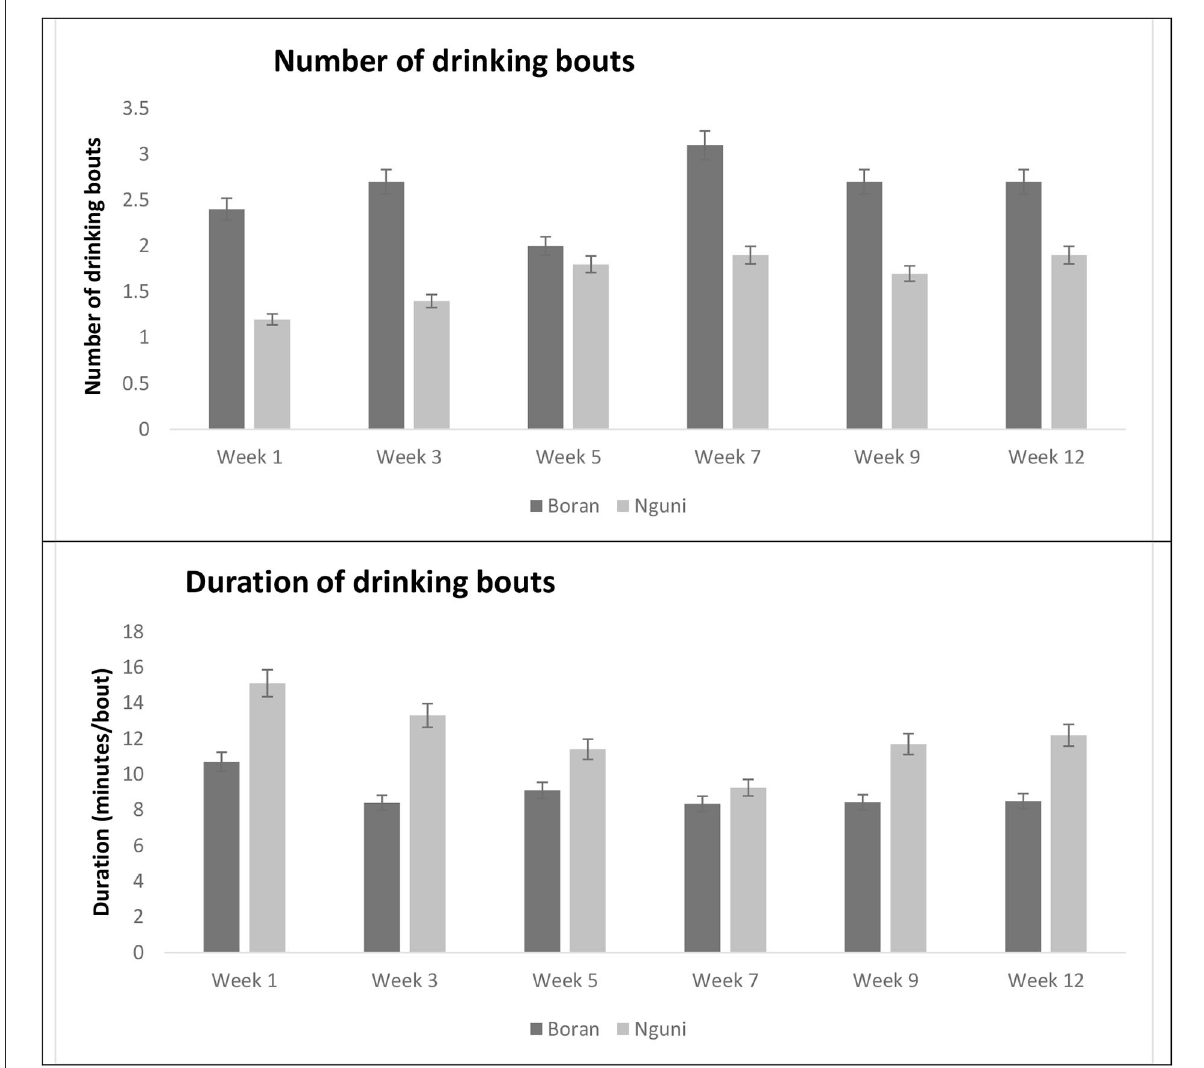
FIGURE3 LSMeans for the proportion of time spent on pasture water points, fenceline, and shade according to breed and observation period.